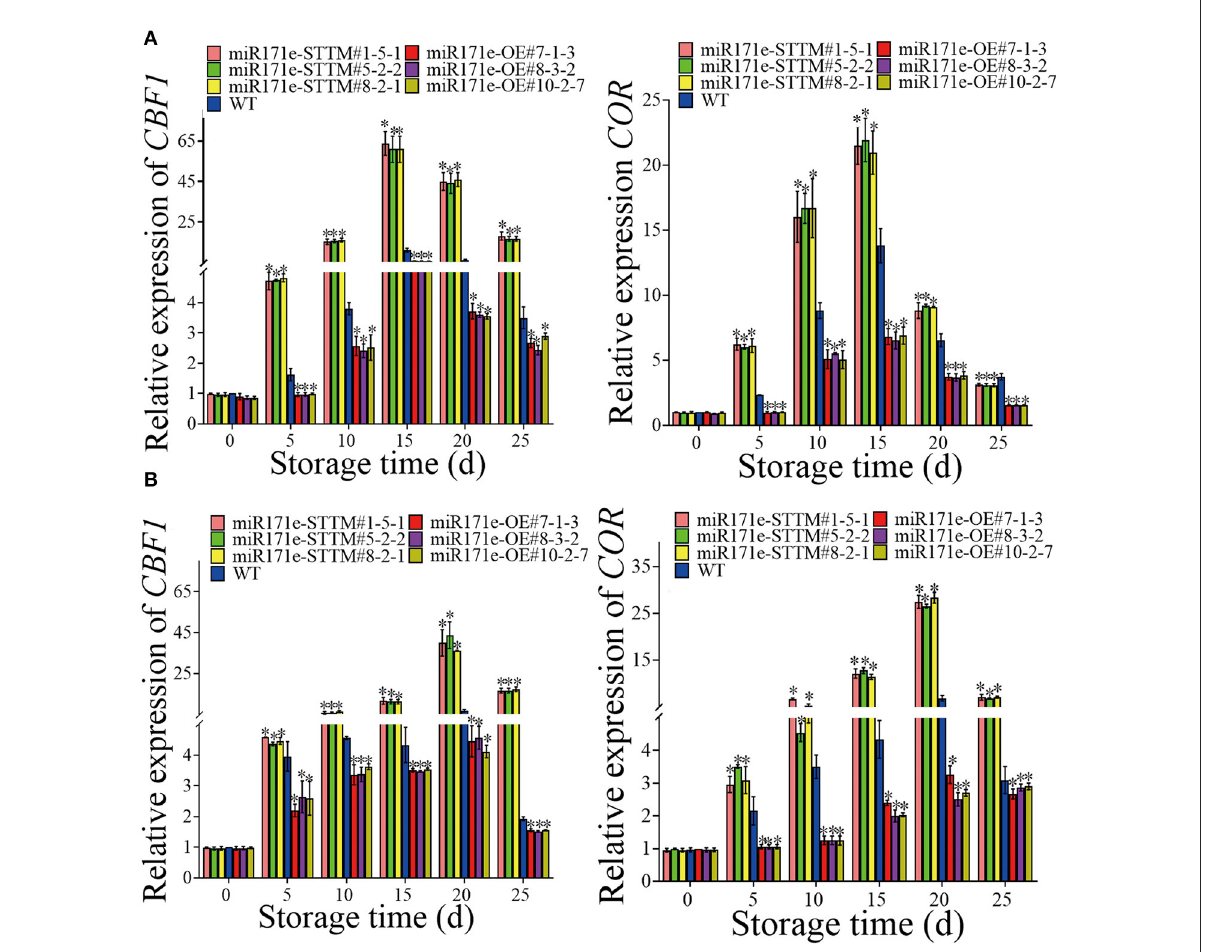
FIGURE6 The relative expression of CBF1 and COR in tomato fruit at MR (A) and MG stage (B) . Vertical bars represent standard deviations of the means, n = 3. Asterisks indicate the statistical difference in the significance at * p <